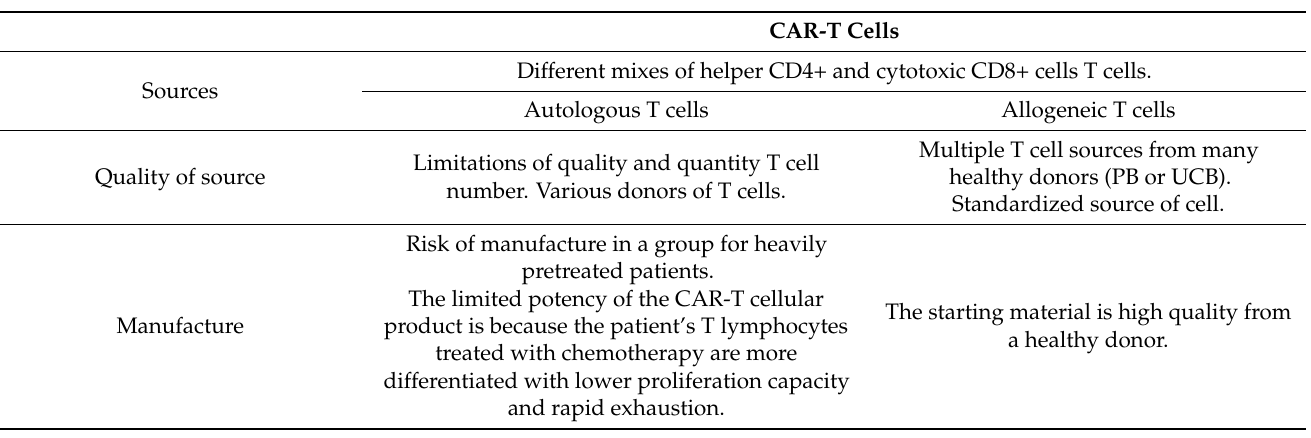
Table 2. Comparison between autologous and allogeneic cells used in CAR-T therapy